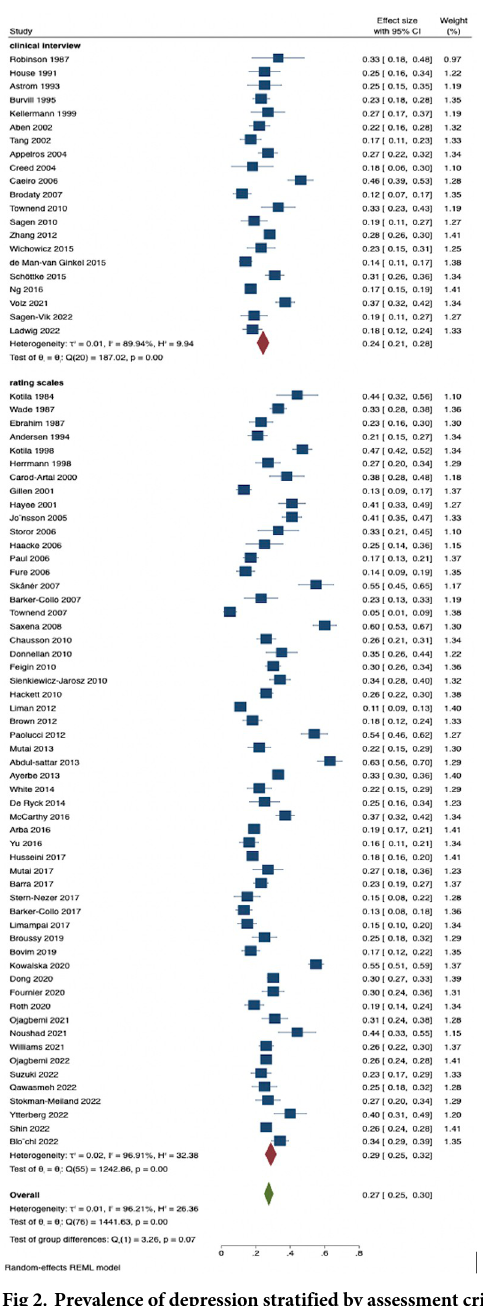
Fig 2. Prevalence of depression stratified by assessment